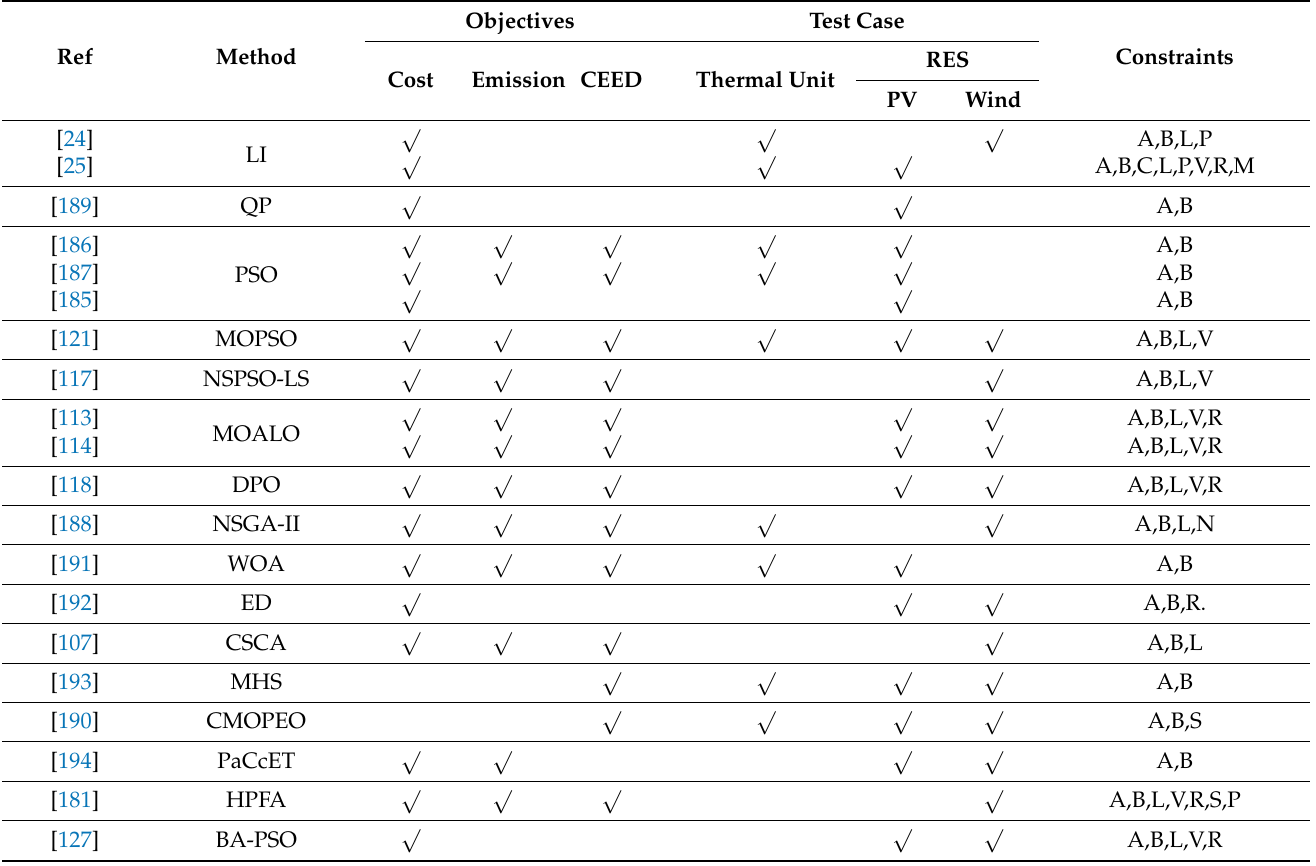
Table 5. Summary of CEED problem using PV solar and wind